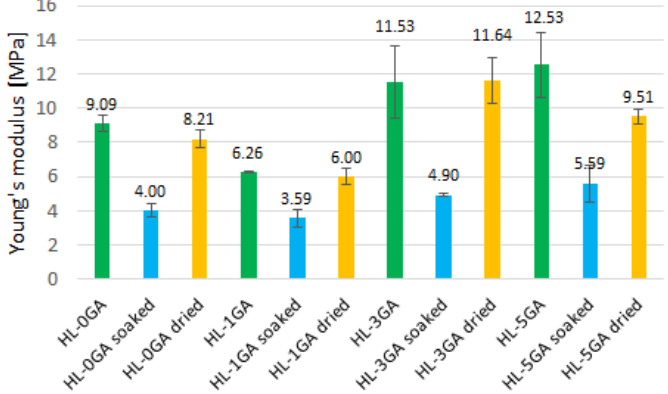
Figure 15. Young’s modulus of the composites (error bars = standard Figure 15. Young ’ s modulus of the composites (error bars = standard deviation).